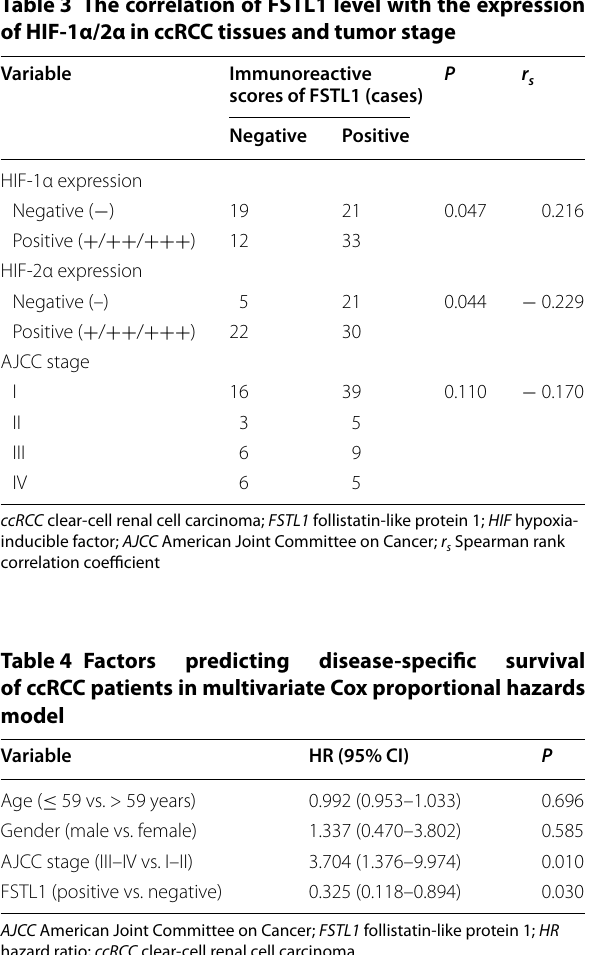
Table 3 The correlation of FSTL1 level with the expression of HIF-1α/2α in ccRCC tissues and tumor stage